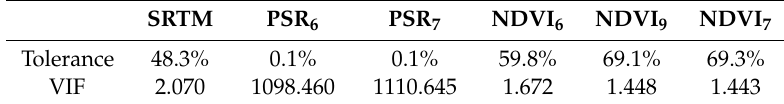
Table 8. Variance inflation factors (VIFs) for the stepwise linear regression (SLR)